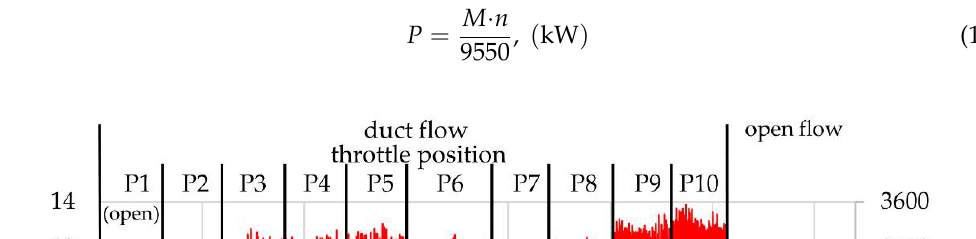
Figure 7. Characteristics of changes in the average power, torque, and speed during tests of fan W1 using Method A (duct flow) with variable damper closure and Method B (open flow).